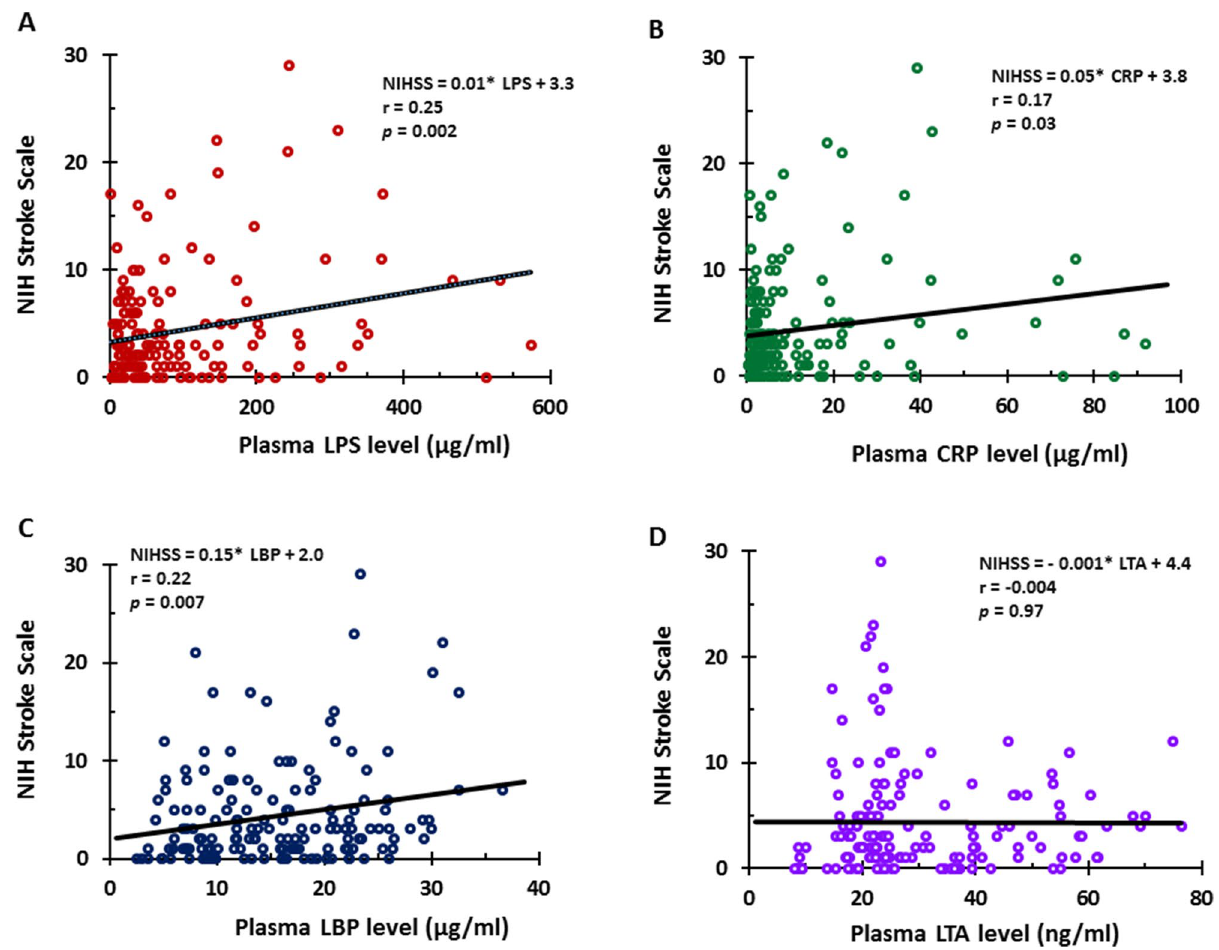
Figure 7. Pearson Correlation Analysis for NIHSS and levels of LPS, LBP, CRP, and LTA from TIA and different causes of stroke. NIHSS correlated with plasma LPS levels ( A ), CRP levels ( B ), LBP levels ( C ) but not with LTA levels ( D ). NIHSS NIH stroke scale, LPS lipopolysaccharide, LBP lipopolysaccharide binding protein, CRP C-reactive protein, LTA lipoteichoic